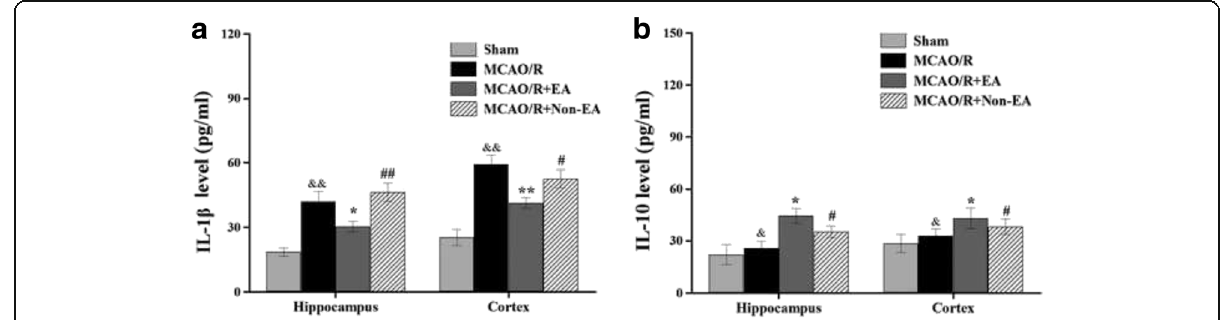
Fig. 5 Effects of EA on inflammatory cytokines levels in the peri-infarct hippocampal CA1and sensorimotor cortex of MCAO/R rats. a Representative and quantitative analysis of ELISA showed that EA treatment for 7 days decreased the levels of IL-1 β and b increased the levels of IL-10 in MCAO/R in- jured rats. Data are presented as mean ± S.E.M. from 6 individual rats in each group. && P < 0.01, & P < 0.05, the MCAO/R group versus the Sham group; ** P < 0.01 * P < 0.05, the MCAO/R + EA group versus the MCAO/R group; ## P < 0.01, # P < 0.05, the MCAO/R + EA group versus the